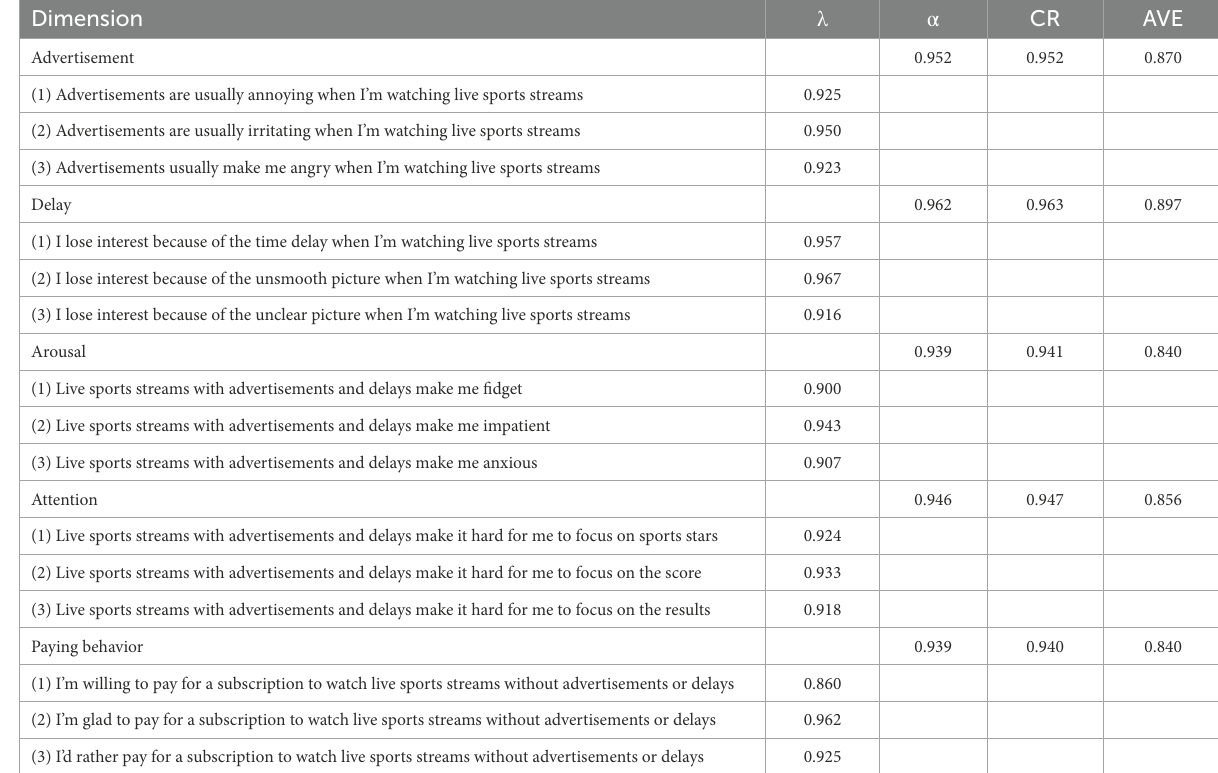
TABLE 2 CFA results for measurement model ( n = 430). Dimension